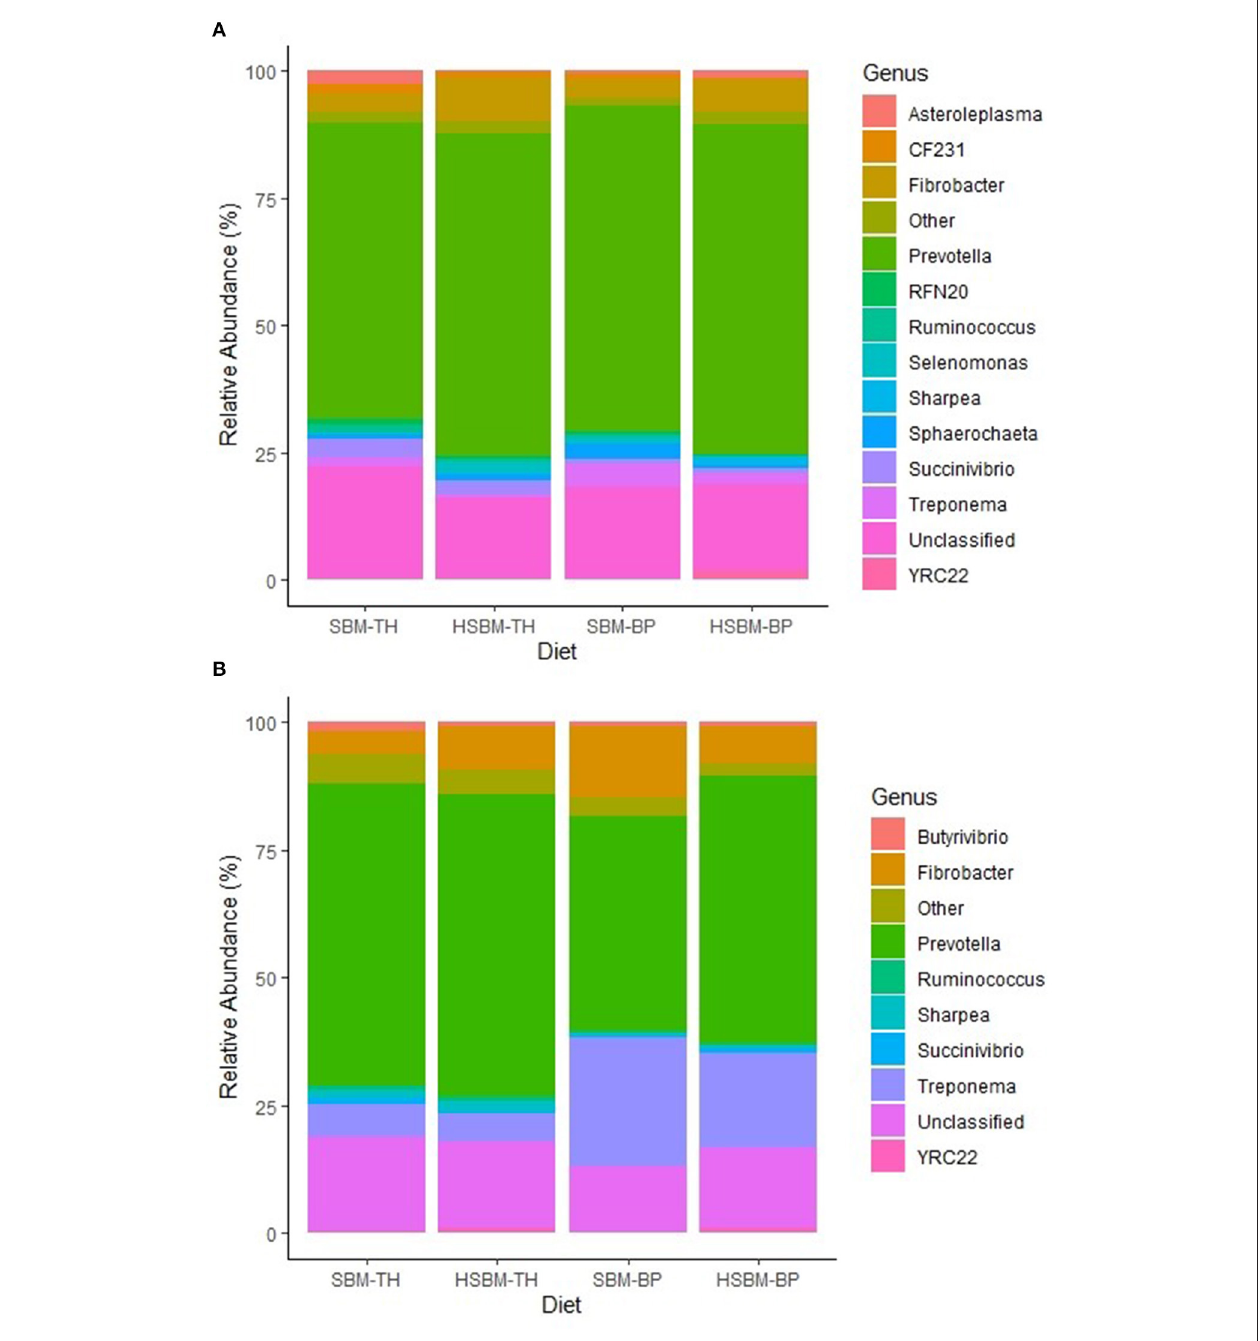
FIGURE 3 | (A) Genus-level composition of bacteria identified in the rumen fluid fraction as differentiated by diet. The category “Other” is comprised of taxa with relative abundances < 1.0% for all diets. (B) Genus-level composition of bacteria identified in the rumen solid fraction as differentiated by diet. The category “Other” is comprised of taxa with relative abundances < 1.0% for all